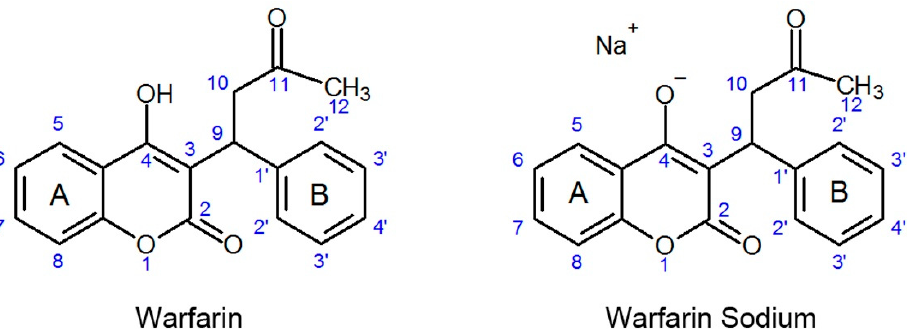
Figure 1. The molecules of warfarin [12] and warfarin sodium [13]. The OH group at C4 atom of warfarin is deprotonated to form warfarin sodium.